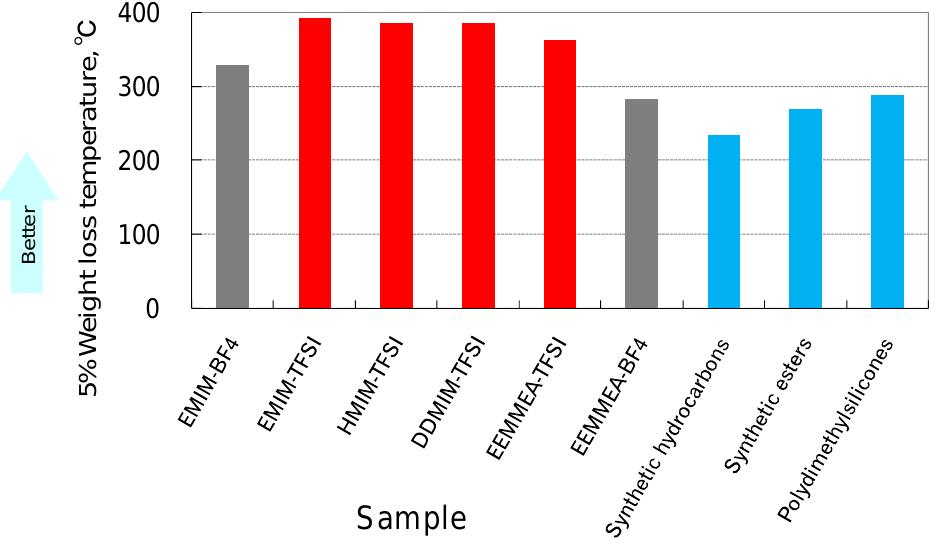
Figure 8. Thermogravimetric analysis: Temperature for 5% weight